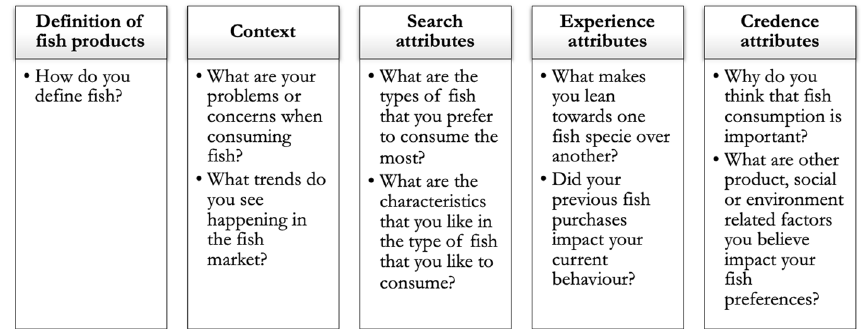
Fig. 1 Thematic categorization of focus